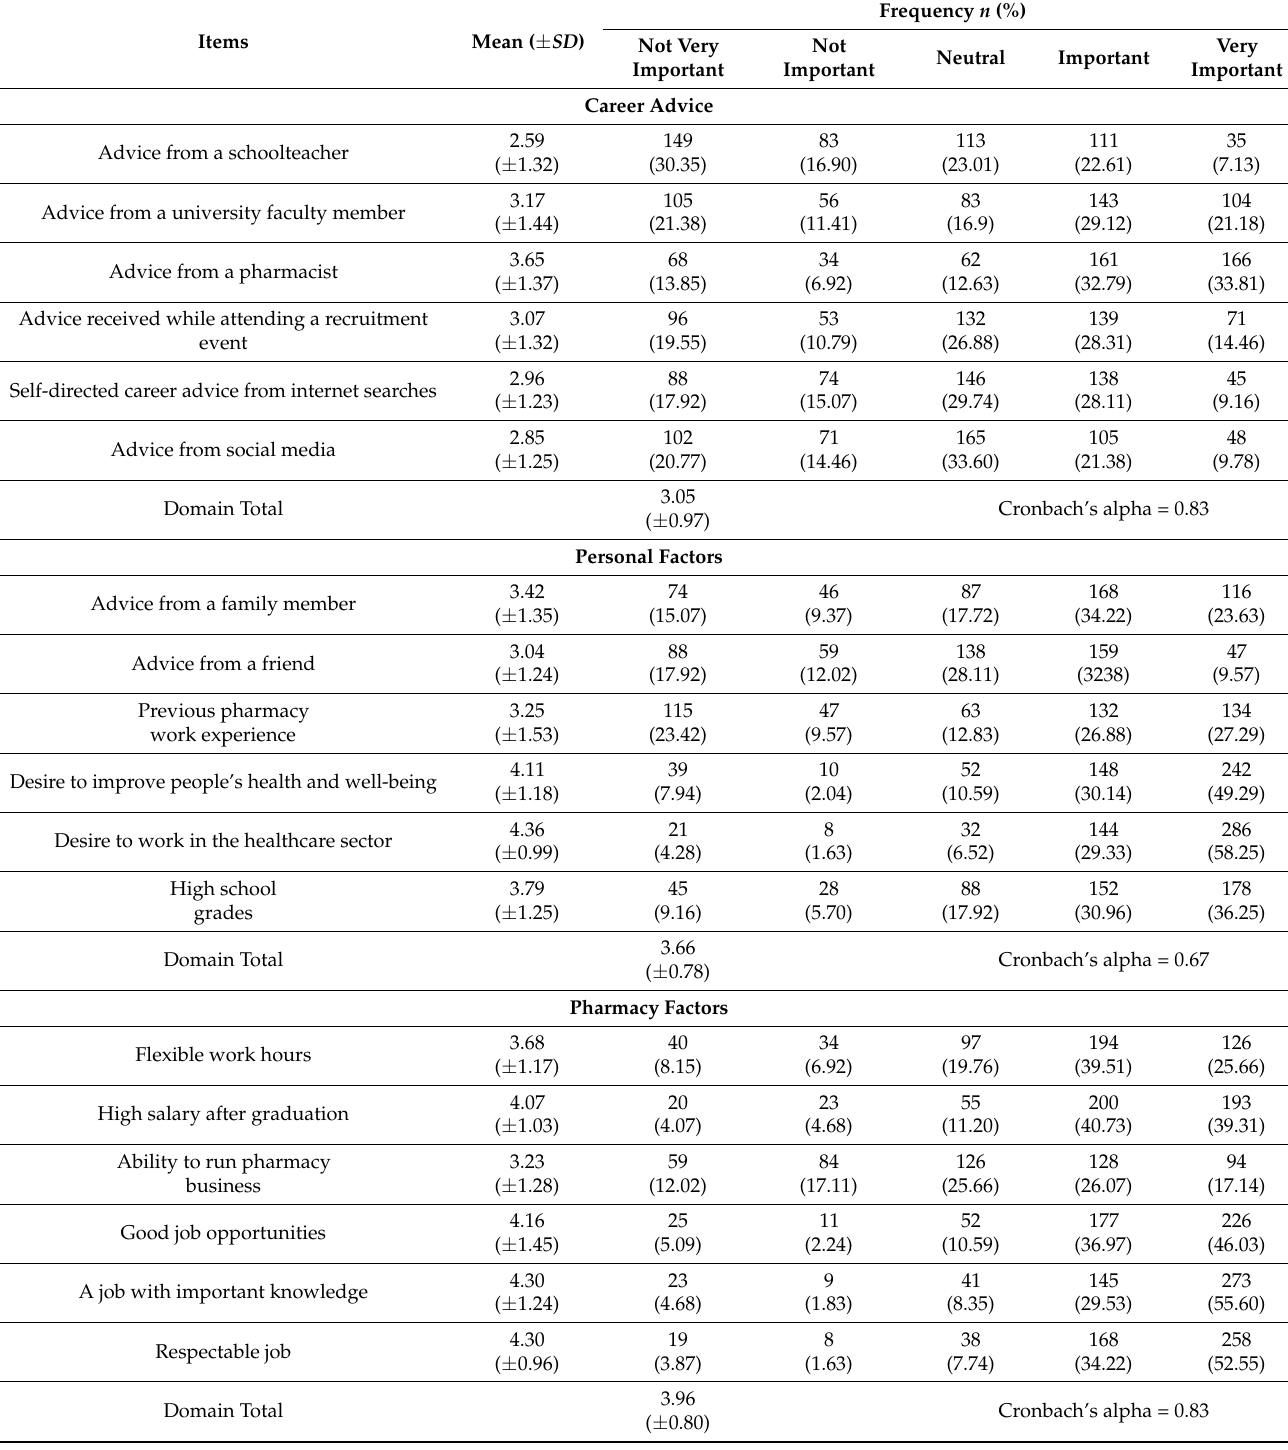
Table 2. Students’ reasons for choosing pharmacy as a major ( n =